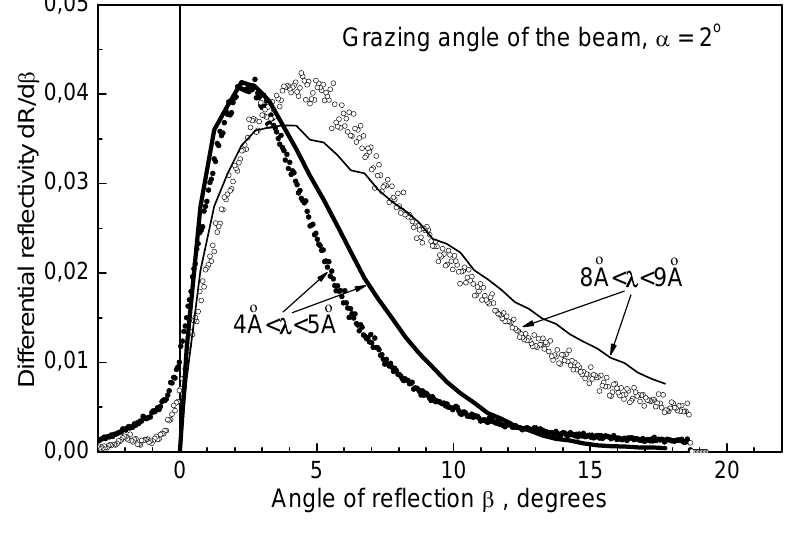
Figure 3. Angular distributions of reflected neutrons. The incidence angle is equal 2°. Dark and empty circles correspond to measured data; solid lines illustrate